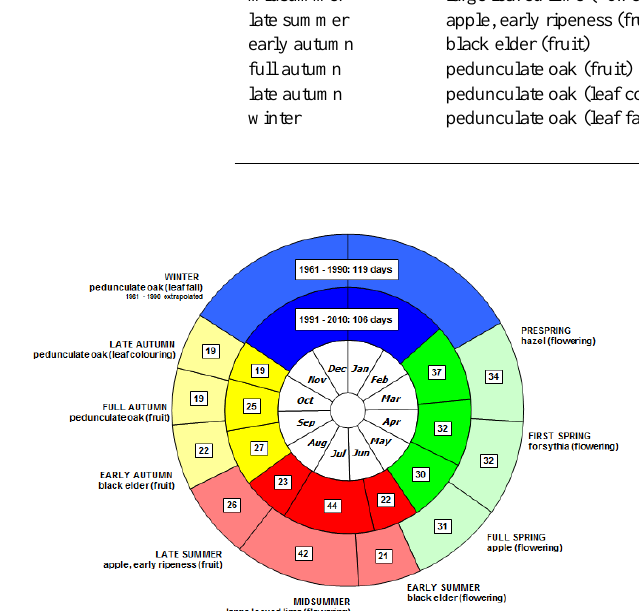
Figure 5. Phenological clock for Germany: indicator phases, mean beginning and duration of the phenological seasons. In this clock, the periods 1961–1990 and 1991–2010 are